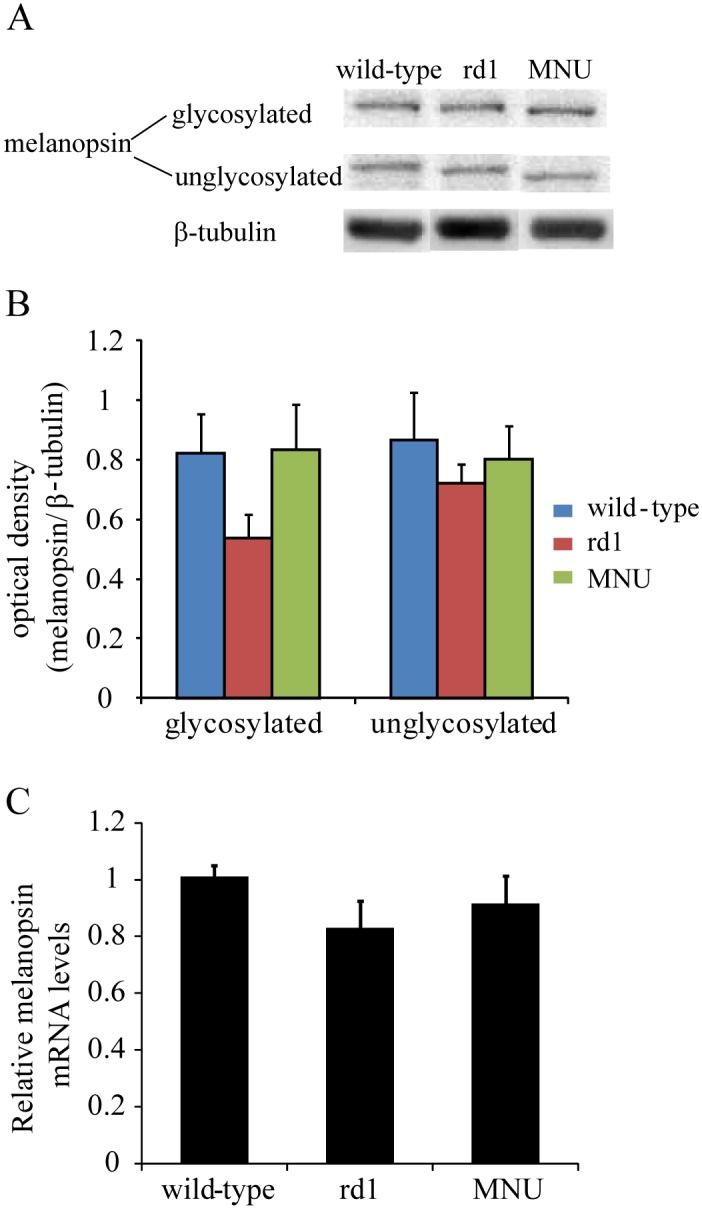
Melanopsin expression levels in retina were unaltered following photoreceptor loss in both rd1 and MNU-injected mice.(A) Representative immunoblots for melanopsin and the corresponding β-tubulin for wild-type, rd1 and MNU-injected mice. Melanopsin immunoblot produced two bands: glycosylated protein at 85 kDa and unglycosylated protein at 53 kDa. (B) Optical density ratio (melanopsin to β-tubulin) for glycosylated and unglycosylated melanopsin (mean±SE). The levels of glycosylated and unglycosylated melanopsin in rd1 (0.54 ± 0.08 and 0.72 ± 0.07, respectively) and MNU-injected mice (0.84 ± 0.15 and 0.8 ± 0.11) were statistically similar to those in wild-type (0.82 ± 0.13 and 0.86 ± 0.16) (F2,9 = 1.8, P = 0.22 and F2,9 = 0.36, P = 0.7, respectively; one-way ANOVA; n = 4 mice). (C) Relative levels of melanopsin mRNA in rd1 (0.83 ± 0.09) and MNU-injected mice (0.92 ± 0.1) were statistically similar to those in wild-type (1.01 ± 0.04) (F2,30 = 1.25, P = 0.3; one-way ANOVA; n = 11 mice).